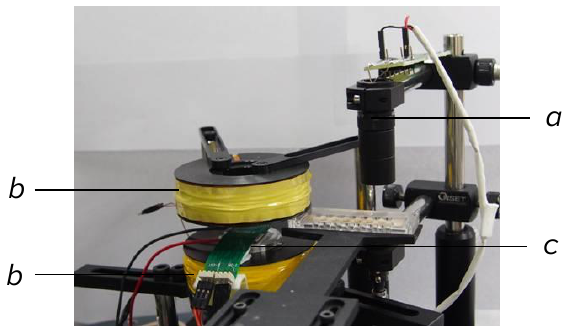
Figure 3. Experimental setup of the magnetically actuated platform. a: digital camera attached with a CCD; b: Helmholtz coil; c: magnetically actuated chip.